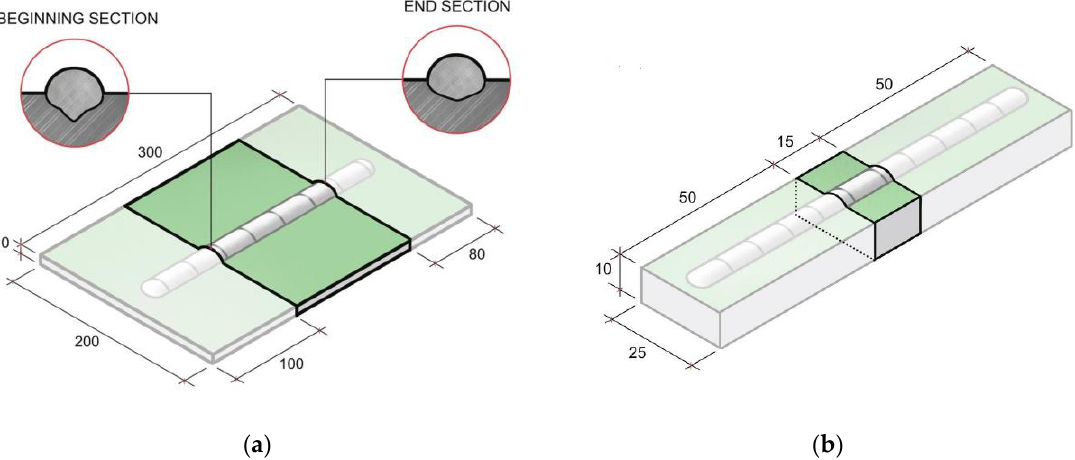
Figure 2. Samples for non-metallic inclusions investigation ( a ) and diffusible hydrogen amount determination ( b ). Table 3. Used